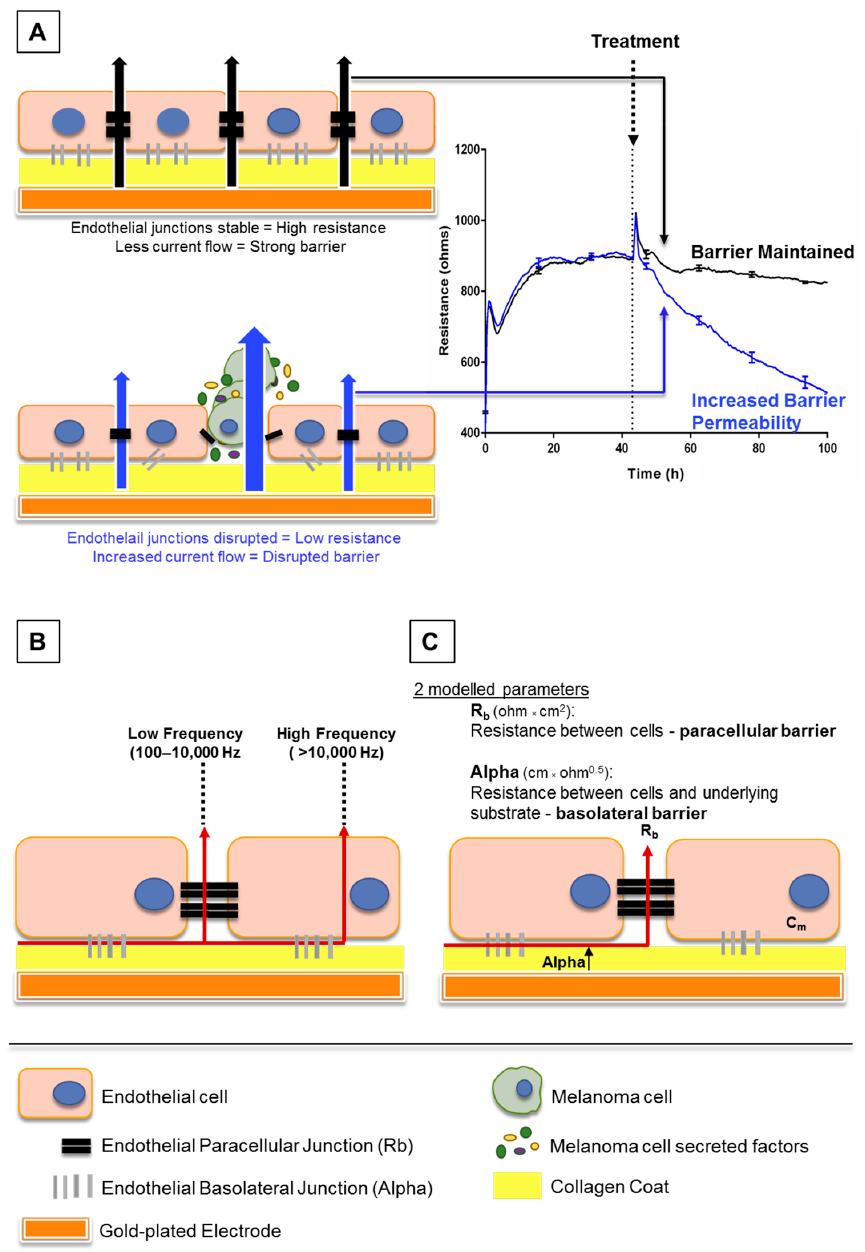
Figure 1. Schematic explaining electric cell-substrate impedance sensing (ECIS) theory. ( A ) This shows endothelial cells growing on gold electrodes which are coated with rat tail collagen I. The endothelial cells form a monolayer by forming junctions with each other and the collagen substrate, shown by black and grey bars respectively. Once these junctions are formed, less current, supplied by the electrode, can flow through the cell junctions. This increases the electrical resistance as seen on the graph (right). As the cells become confluent, maximum resistance is achieved and the resistance plateaus. Upon treatment with factors that disrupt the endothelial barrier, the junctions weaken, current flows more freely between the cells and the electrical resistance decreases (blue trace, right). ( B) This shows how the ECIS data can be modelled depending on the frequency at which the current is applied by the electrodes. At low frequencies (100–10,000 Hz), current flows only between cells, whereas at high frequencies ( > 10,000 Hz), the current can also flow through cells. ( C ) Collectively, the low and high frequency data can be modelled to provide information on the resistance between cells (Rb) and resistance between cells and the underlying substrate